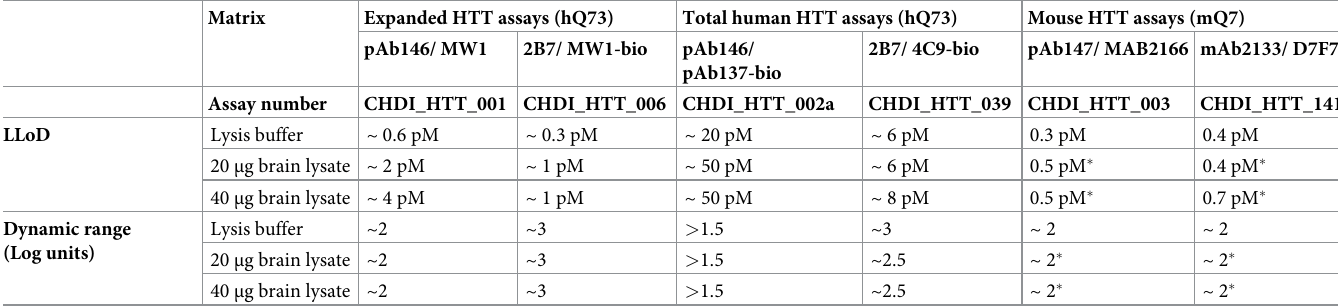
Table 1. Sensitivity of HTT immunoassays compared to existing described in this paper. Recombinant human HTT-Q73 (1–573) or mouse full-length HTT-Q7 was spiked into lysis buffer or mouse brain lysate (derived from wild type or homozygous zQ175DN mice for spiking human or mouse recombinant HTT, respectively). Serially dilutions of recombinant HTT in each of the matrices were measured with the indicated HTT MSD immunoassays (indicated as antibody pairs: capture/ detection), and LLoD concentration was back-calculated based on mean background signal + 3 x standard deviation. Dynamic range was estimated visually from the standard curves, which are shown in S4 Fig. � determined in 3 and 10 μ g brain lysate instead of 20 and 40 μ g, respectively.